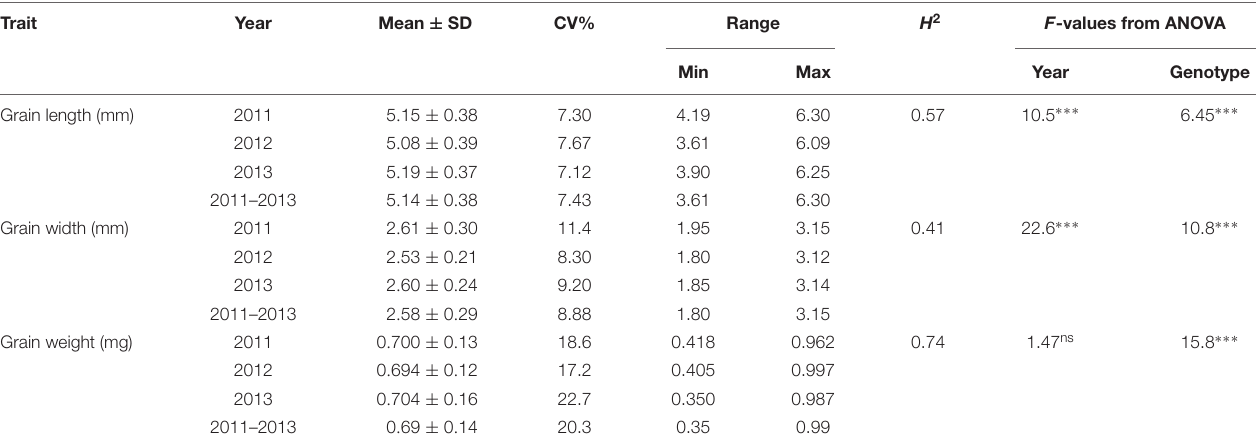
TABLE 1 | Descriptive statistics, broad sense heritability ( H 2 ) and F -value from analysis of variance for the grain size descriptors in year 2011, 2012, and 2013.